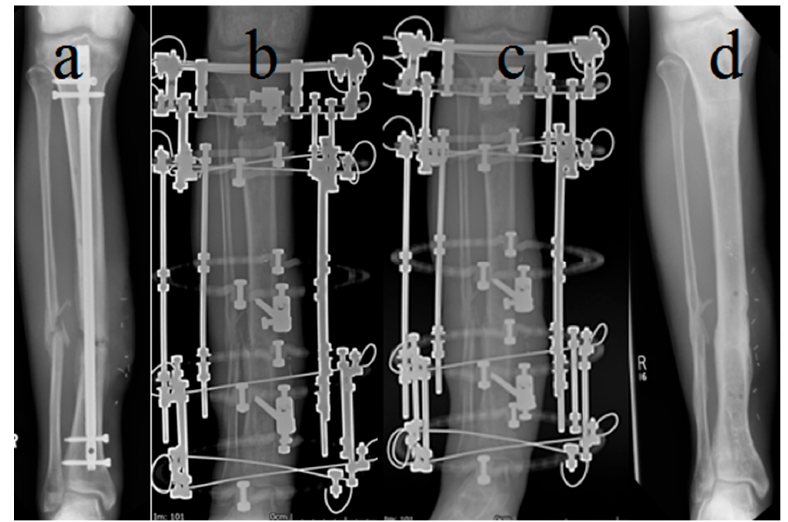
Figure 1. Acute shortening with relengthening. ( a ) Open fracture of tibia treated with early debridement, IM nailing and flap cover. Presented at three months, with a discharging sinus and exposed medial tibial bone. ( b ) A 2.5 cm resection was required. The tibia was acutely shortened to good bone contact and the flap reused to cover the defect. ( c ) Distraction was performed at 1 mm per day through the proximal corticotomy ( b ) and continued until equal leg length was achieved (at four weeks after surgery). ( d ) Eight months after surgery, the tibia was solidly healed with good alignment and no evidence of